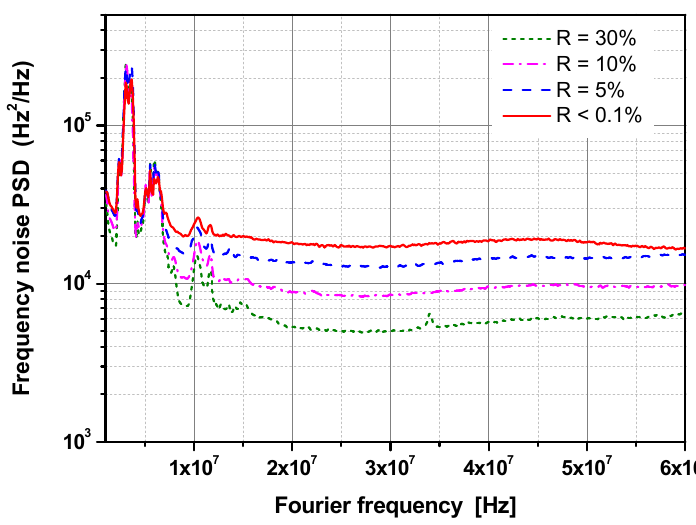
Figure 3. Frequency noise PSD (power spectral density) of the laser beat note signal in a self-delayed heterodyne setup at 85 mW output power for lasers with various front facet reflection: R < 0.01% (red solid); R = 5% (blue dashed); R = 10% (pink dot-dashed); and R = 30% (green short dashed).